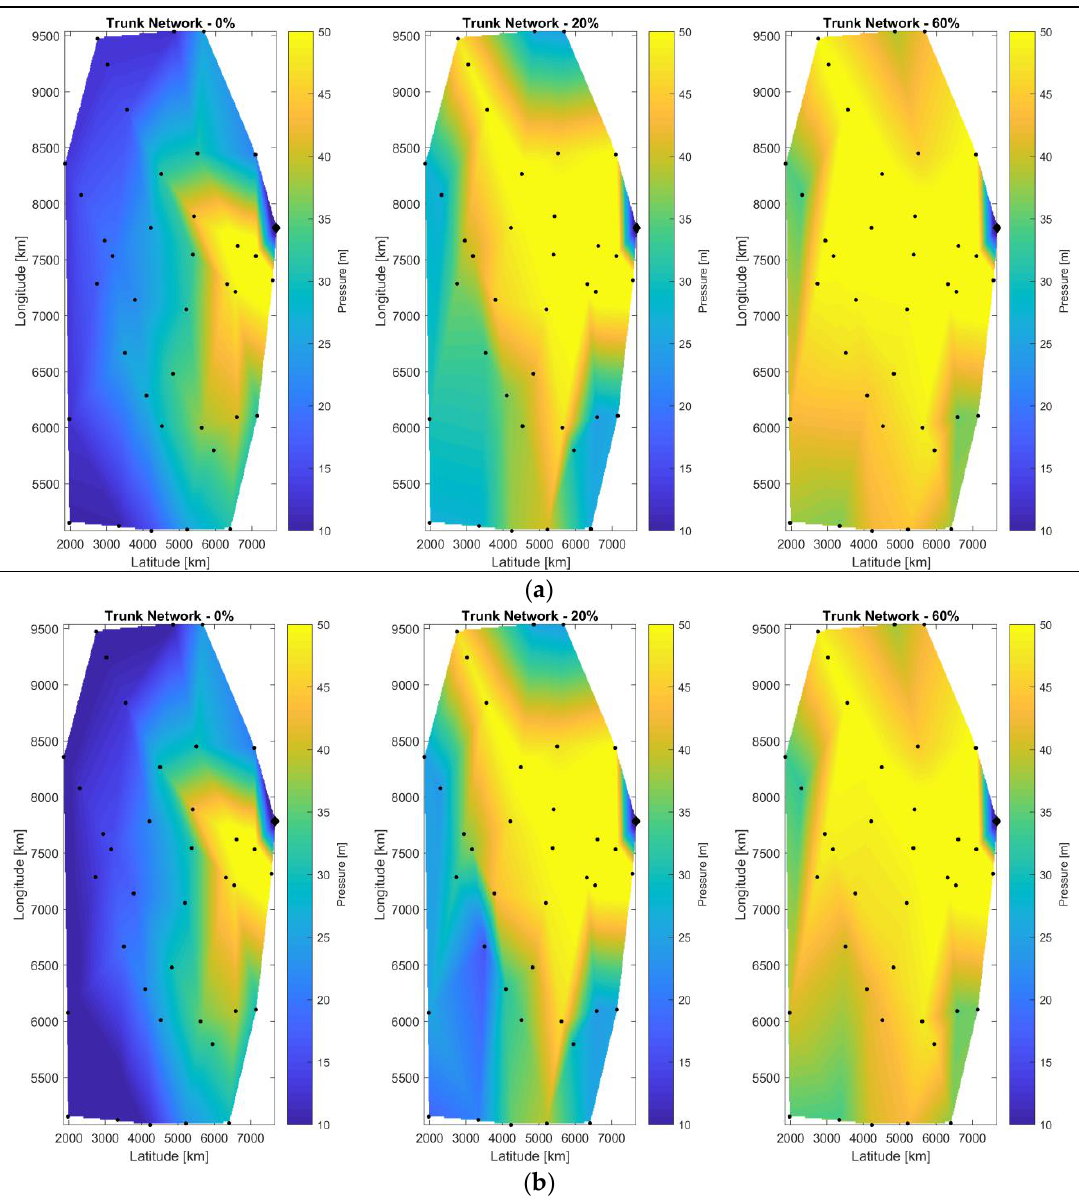
Figure 11. Pressure zones for the initial scenario and for TNs with 20% and 60% of the pipes: ( a ) Without leakage; and, ( b ) Pipe burst on node 22.